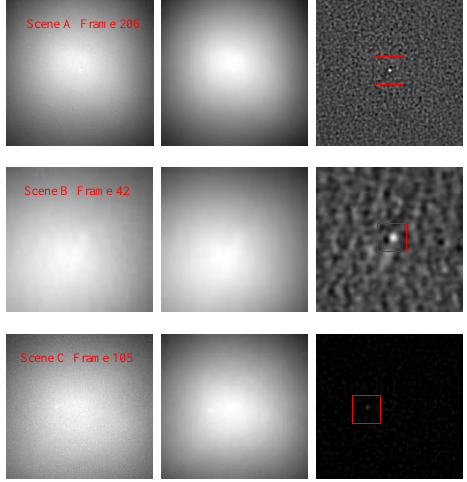
Figure 10. The background suppression effect of SPB under the different motion trajectories of the targets of scenes A, B, and C.